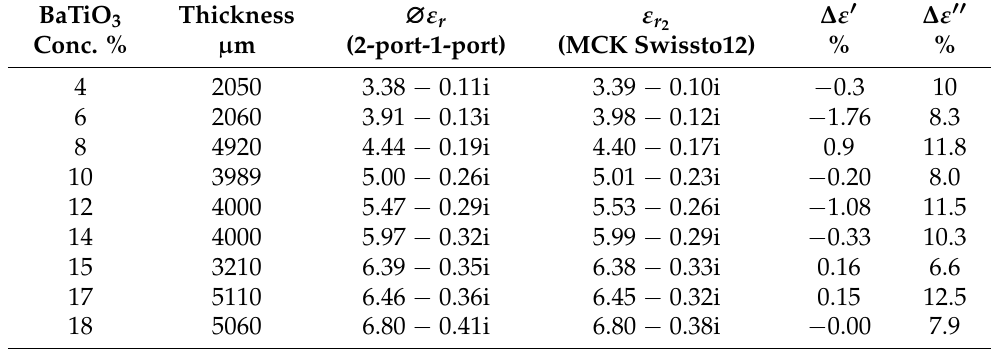
Table 1. Material characterization results from the 2-port-1-port setups and the swissto12